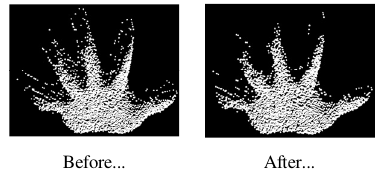
Figure 5: Example of noise removal using the point density .